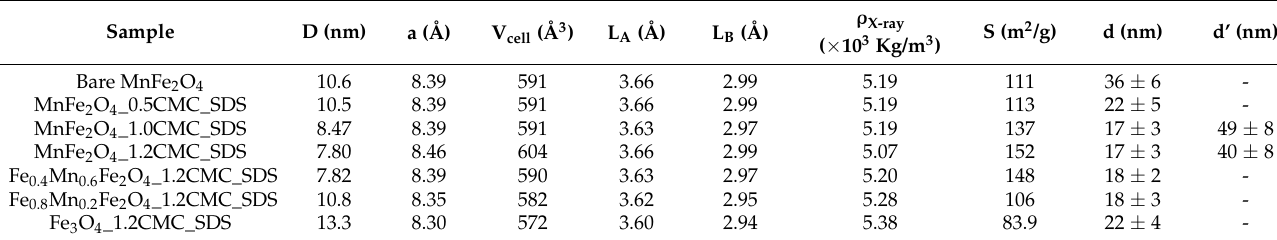
Table 1. Average crystallite size (D), lattice constant (a), unit volume cell (V cell ), hopping length for tetrahedral site (L A ), hopping length for octahedral site (L B ), X-ray density ( ρ x − ray ), specific surface area (S), particle size (d), ag- gregated particle size (d’) of the synthesized bare MnFe 2 O 4 , MnFe 2 O 4 at various SDS surfactant concentrations,